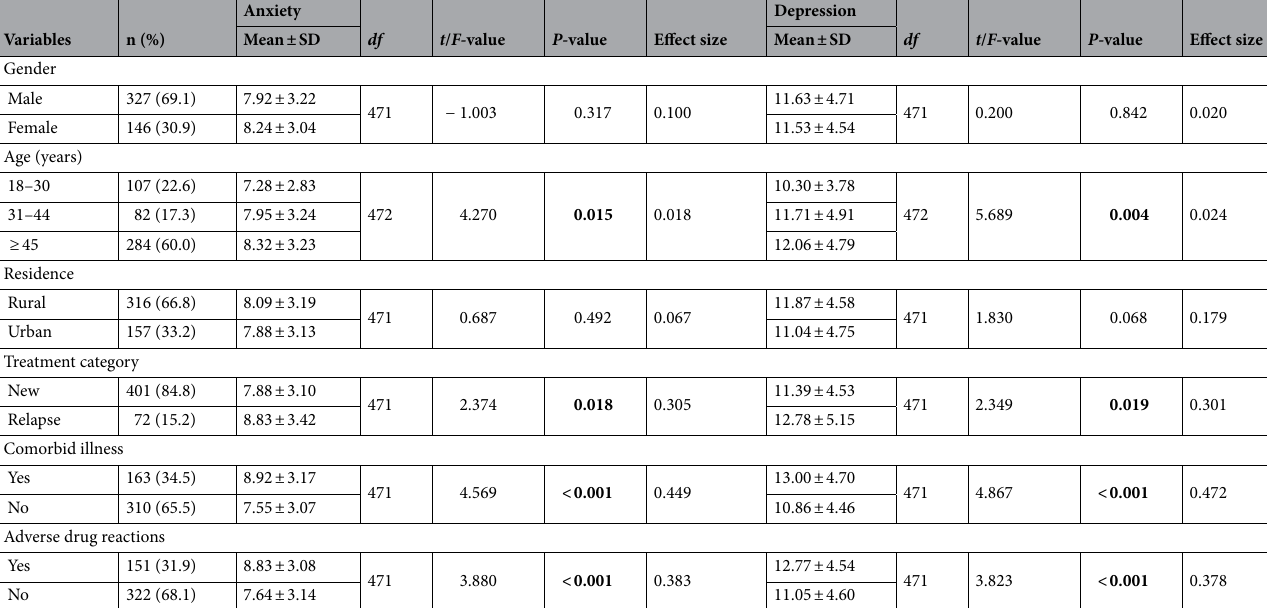
Table 1. Demographic characteristics and treatment status of TB patients and univariate analysis for the factors in relation to anxiety and depression. Significant values are in bold. SD standard deviations, df degrees of freedom.